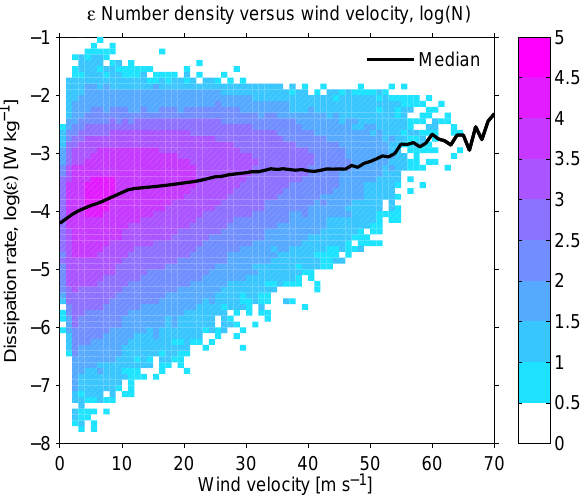
Figure 13. Number density of the derived turbulent energy dissipa- tion rate ε vs. wind velocity (horizontal) derived from the radar mea- surements with MAARSY in the years of 2010–2013. The condition with stronger winds tends to lead to the occurrence of stronger tur- bulence, whereas weaker turbulence only occurred where there was weaker wind. The ε median for every 1ms − 1 interval of wind ve- locity shown in black reveals an increase with the increased wind velocities.